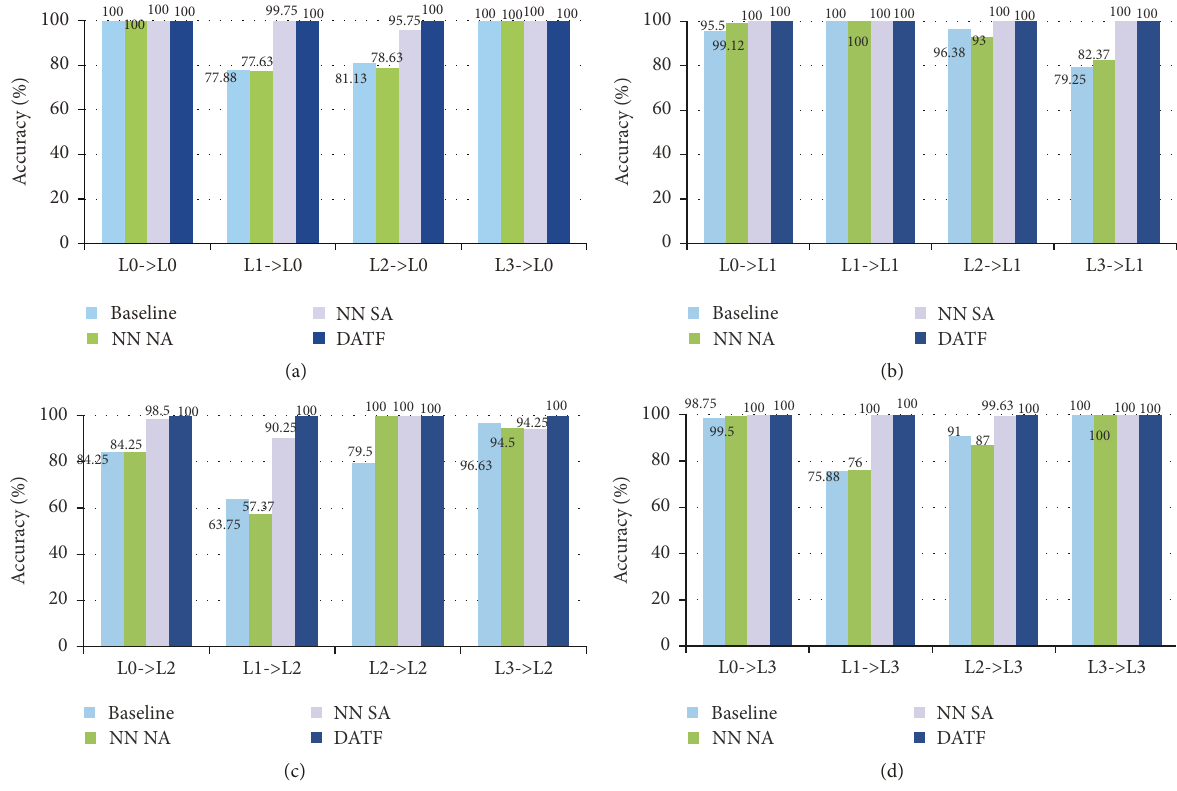
Figure 4: The results with fault size being